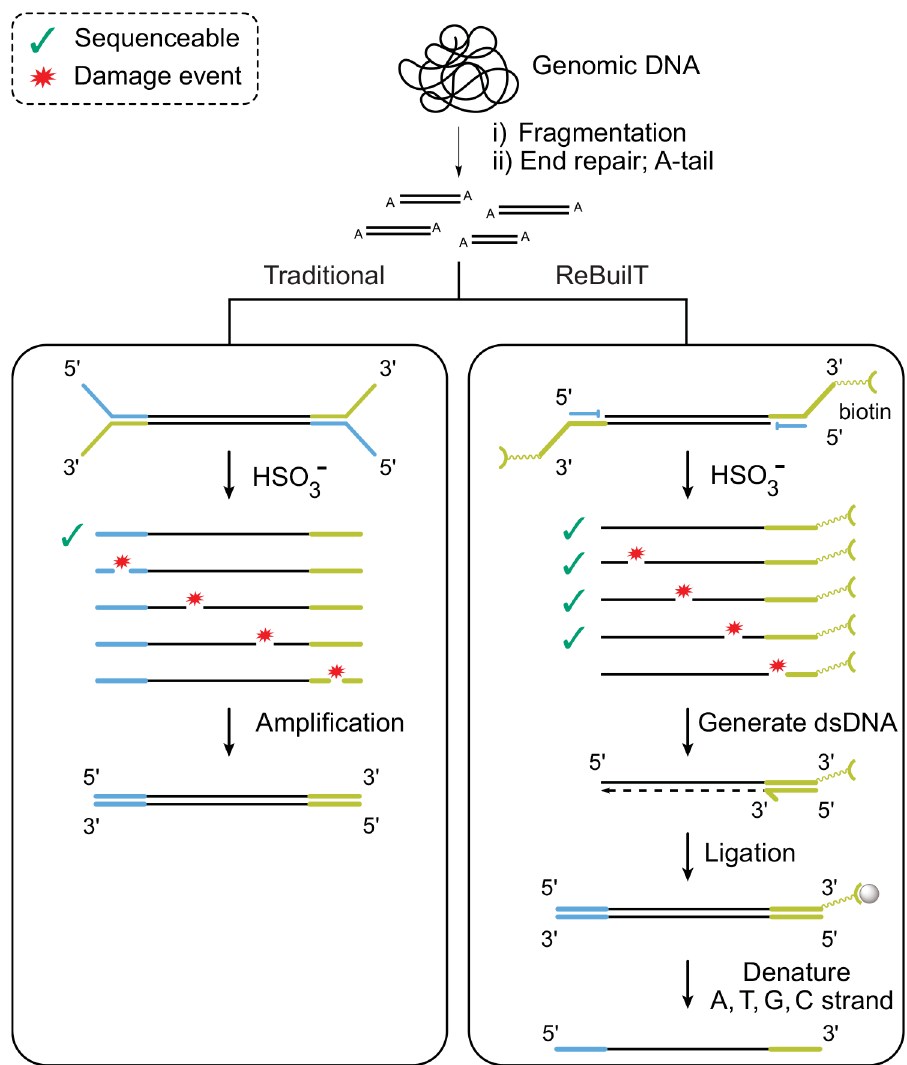
Fig 1. Schematic describing key differences between the ReBuilT and PCR-BS protocols. The possible fragments generated by cleavage (indicated with red stars) during bisulfite treatment are illustrated, and annotated to indicate if they remain sequenceable. Left track: adapter ligation precedes bisulfite treatment, after which the few surviving fragments are amplified by PCR. Right track: a single-stranded 3 0 selective adapter ligation precedes bisulfite treatment. A primer extension generates dsDNA, which is immobilized on magnetic beads. A second ligation is performed before the non-uracil containing strand is denatured ready for